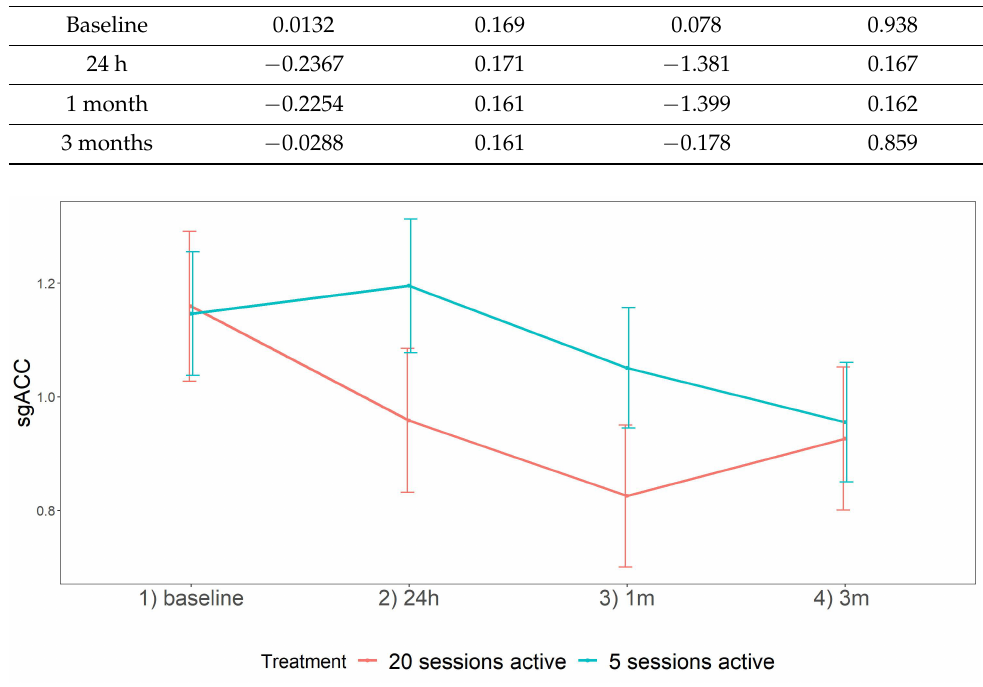
Figure 3. Line plot for sgACC for both 5-sessions and 20-sessions treatment group at each individual time moment. SEs are displayed as error